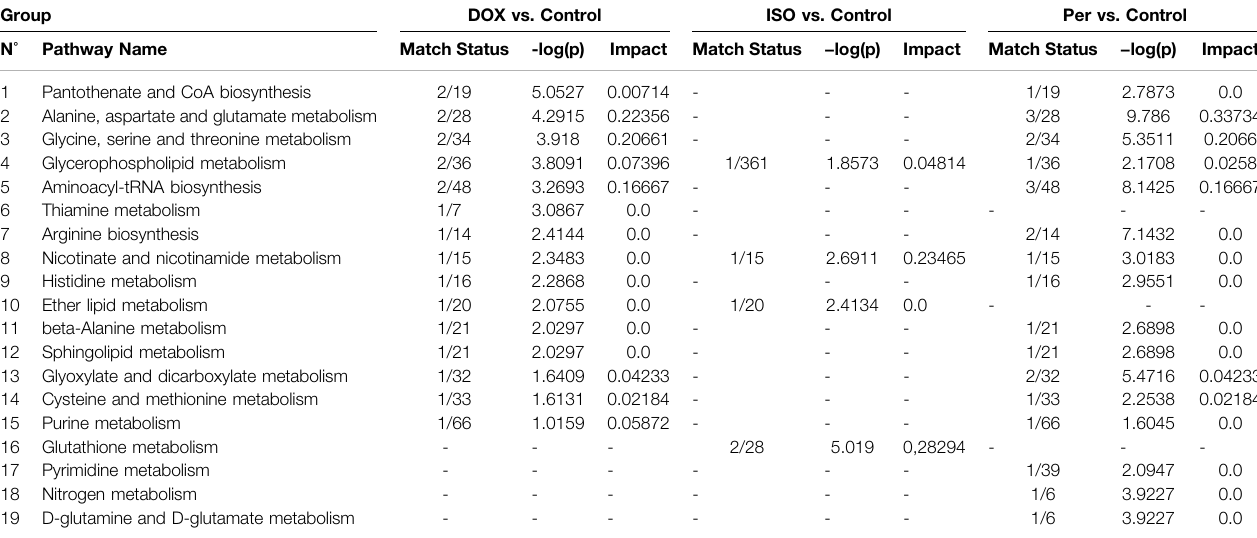
TABLE 2 | Pathway Analysis Parameters Comparisons - Level of correspondence, negative p -value logarithm and impact obtained from the pathway analysis of H9c2 cell extracts. Group DOX vs. Control ISO vs. Control